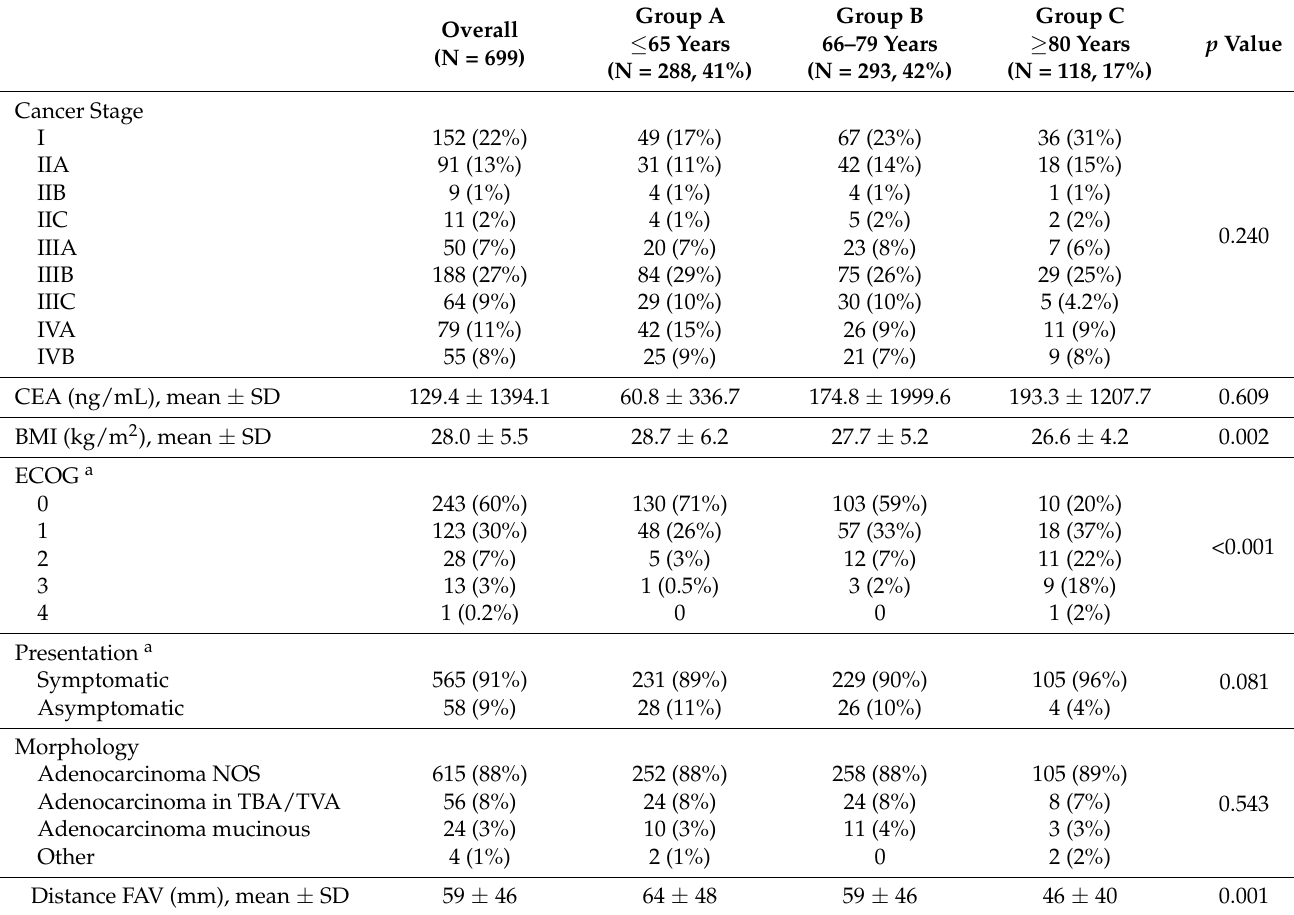
Table 1. Clinical characteristics of patients with rectal cancer by age group. The table here demonstrates a comparison of the entire cohort of patients, regardless of whether or not they underwent a surgical